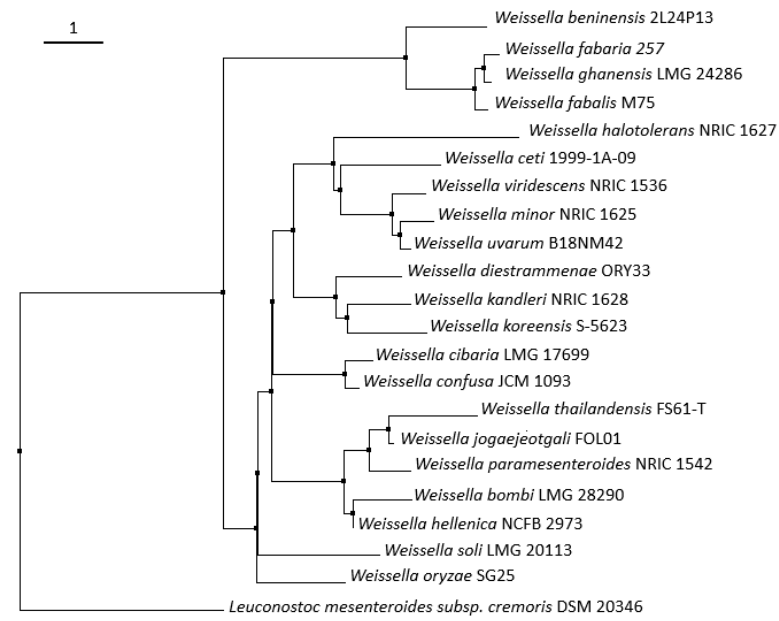
Figure 1. Neighbour-joining phylogenetic tree based on 16S rRNA gene sequences of Weissella and the related species Leuconostoc mesenteroides obtained from Clustal W2 Multiple Sequence Alignment. The relative genetic distances are indicated by the scale bar and the branch lengths. Weissella species